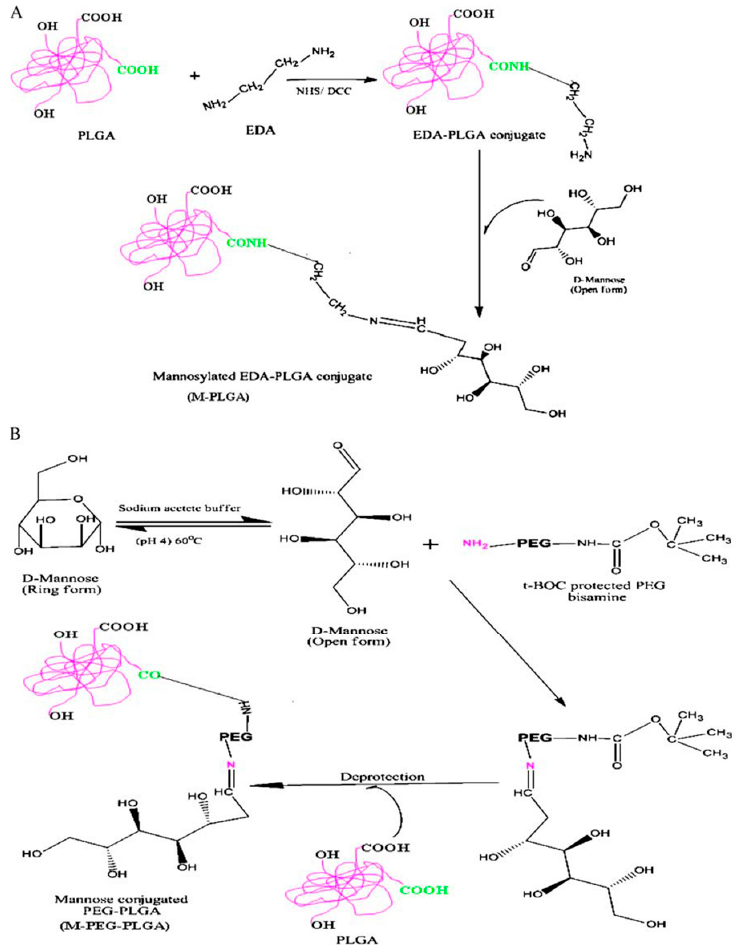
Figure 3. Scheme of synthesis of mannose–PLGA conjugates; ( A ) without spacer (M-PLGA); ( B ) with PEG spacer (M-PEG-PLGA) (from [76]). Table 2. Main features of AmB-Nanoparticles.